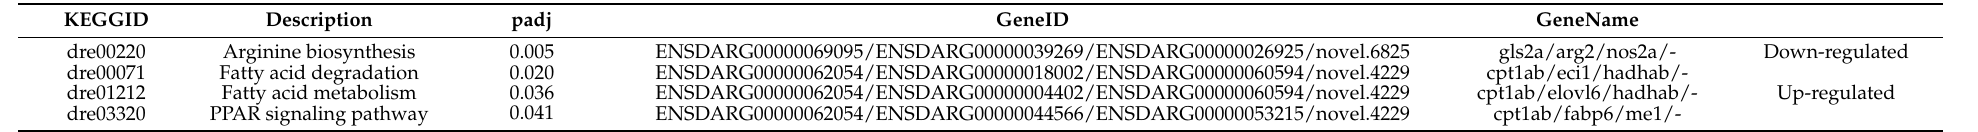
Table 1. Differential genes (padj < 0.05, |log2 (Fold change)| ≥ 1) in the KEGG-related pathways after cyantraniliprole